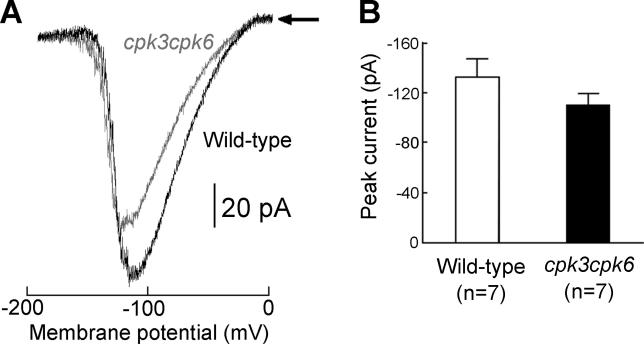
R-Type Anion Channel Currents in cpk3cpk6 Double Mutant and Wild-Type Guard Cells(A) Representative traces of R-type anion channel current in wild-type (black trace) and cpk3-1cpk6–1 double mutant (gray trace).(B) Averages of peak currents of R-type anion channel currents in wild-type (white bar, n = 7) and cpk3-1cpk6–1 double mutant (black bar, n = 7 ± SEM) guard cells.